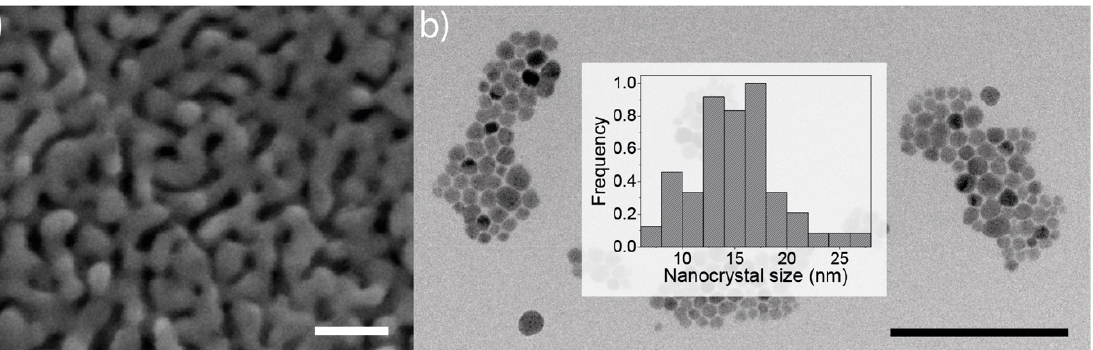
Figure 1. ( a ) SEM image of nanoporous Au; scale bar: 100 nm. ( b ) TEM image of CsPbBr 3 NCs; scale bar 200 nm; in the inset is the size distribution of CsPbBr 3 nanocrystals. X-ray diffraction measurements were performed on a nanocrystal precipitate. Figure 2 reports the Rietveld refinement of the pattern obtained using MAUD software [30]. The CsPbBr 3 NCs are in the orthorhombic γ -phase (Pbnm, space group No. 62, COD ID 1533062), with lattice parameters a = 8.219 Å, b = 8.254 Å, and c = 11.753 Å.